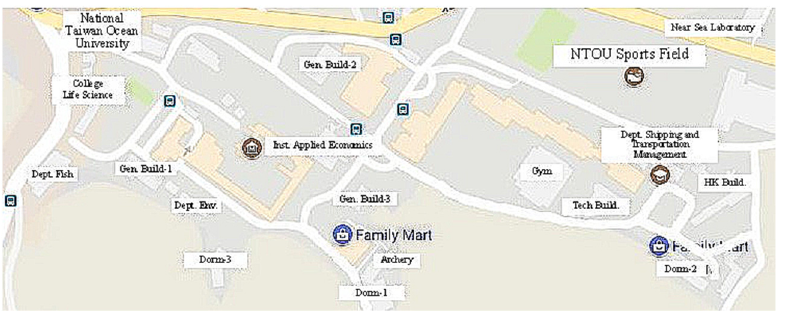
Figure 21. The testing field in National Taiwan Ocean University (WGS84: N25.14993733502751, E121.77837084706557).